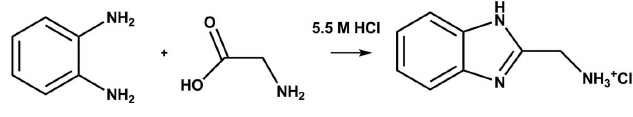
Figure 5 Fingerprint plot of all the contacts.